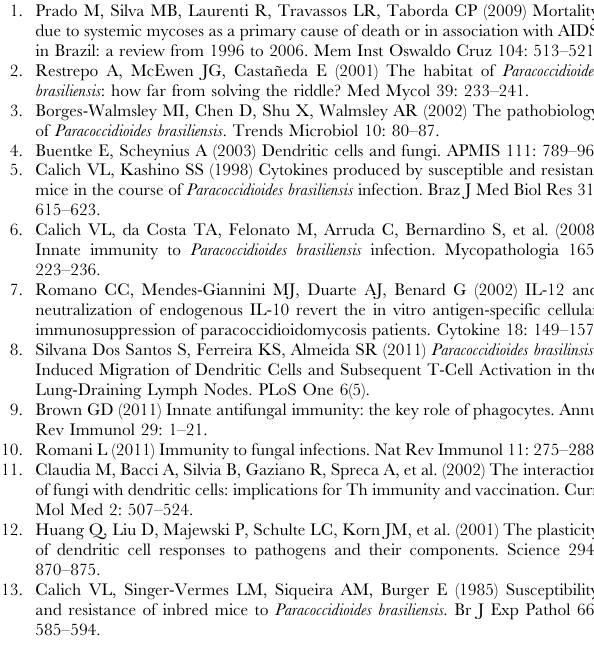
Table S1 Oligonucleotides used for qRT-PCR analysis. Table S2 Complete list of probe sets identified by SAM as being differentially modulated in DCs infected with